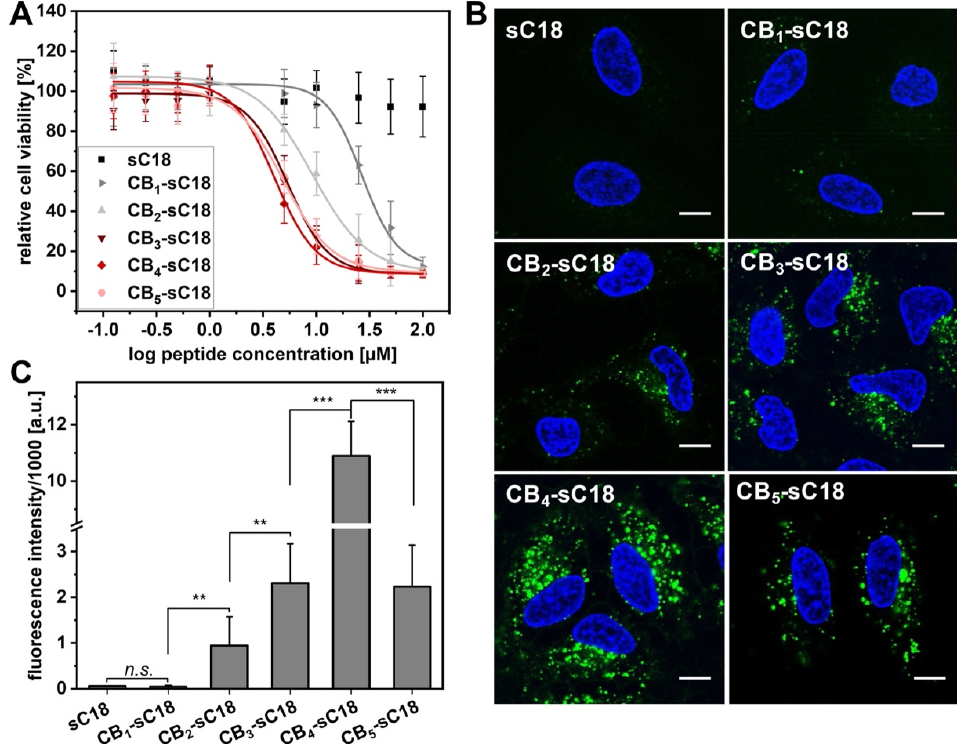
Figure 3. Cytotoxicity and cellular uptake into HeLa cells. ( A ) Cytotoxicity profile of CB-peptide conjugates towards HeLa cells. ( B ) CLSM analysis of 1 µM CF-labeled peptide conjugates after 2 h of incubation in HeLa cells; scale bar: 10 µm. ( C ) Flow cytometry analysis of 1 µM CF-labeled peptide conjugates after 2 h of incubation in HeLa cells. Significances were determined by Student’s t-test (** p < 0.005; *** p < 0.0005). CB 4 -sC18 is significant (*** p < 0.0005) to all conjugates.